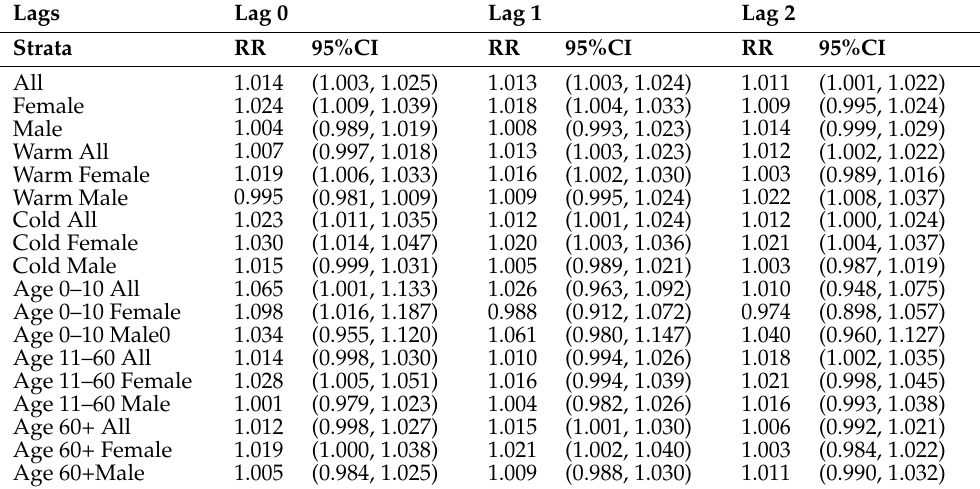
Table 4. Relative risks (RR) and their 95% confidence intervals (95%CI) for an increase in the AQHI level by a one interquartile range (IQR = 1.0). ICD-10 codes: E00–E90; Chapter IV Endocrine, nutritional and metabolic diseases. Data recorded in Toronto, Canada for the period between April 2004 and December 2015.